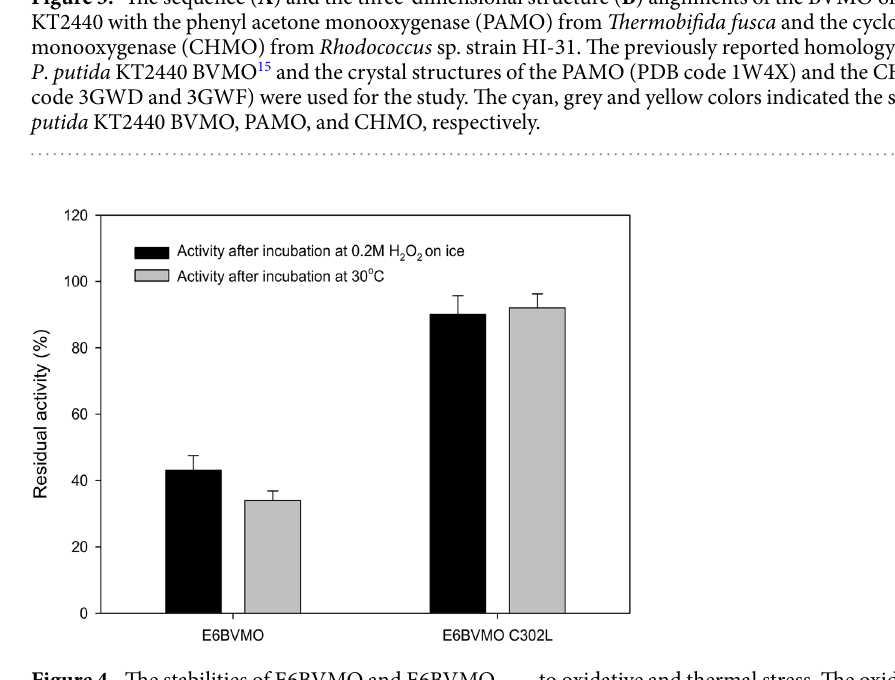
Figure 4. The stabilities of E6BVMO and E6BVMO C302L to oxidative and thermal stress. The oxidative stabilities of the enzymes (black bars) were measured 10 min after incubation at the Tris-HCl buffer (pH 8) containing 0.2 M hydrogen peroxide on ice. The thermal stabilities of the enzymes (grey bars) were evaluated 10 min after incubation at the Tris-HCl buffer at 30 °C. The enzymes, which were purified via affinity chromatography on a Ni-NTA gel matrix, were used. The initial activity of E6BVMO and E6BVMO C302L was 0.9 and 1.0 U/mg proteins, respectively. The experiments were performed in triplicate. The error bars indicate standard